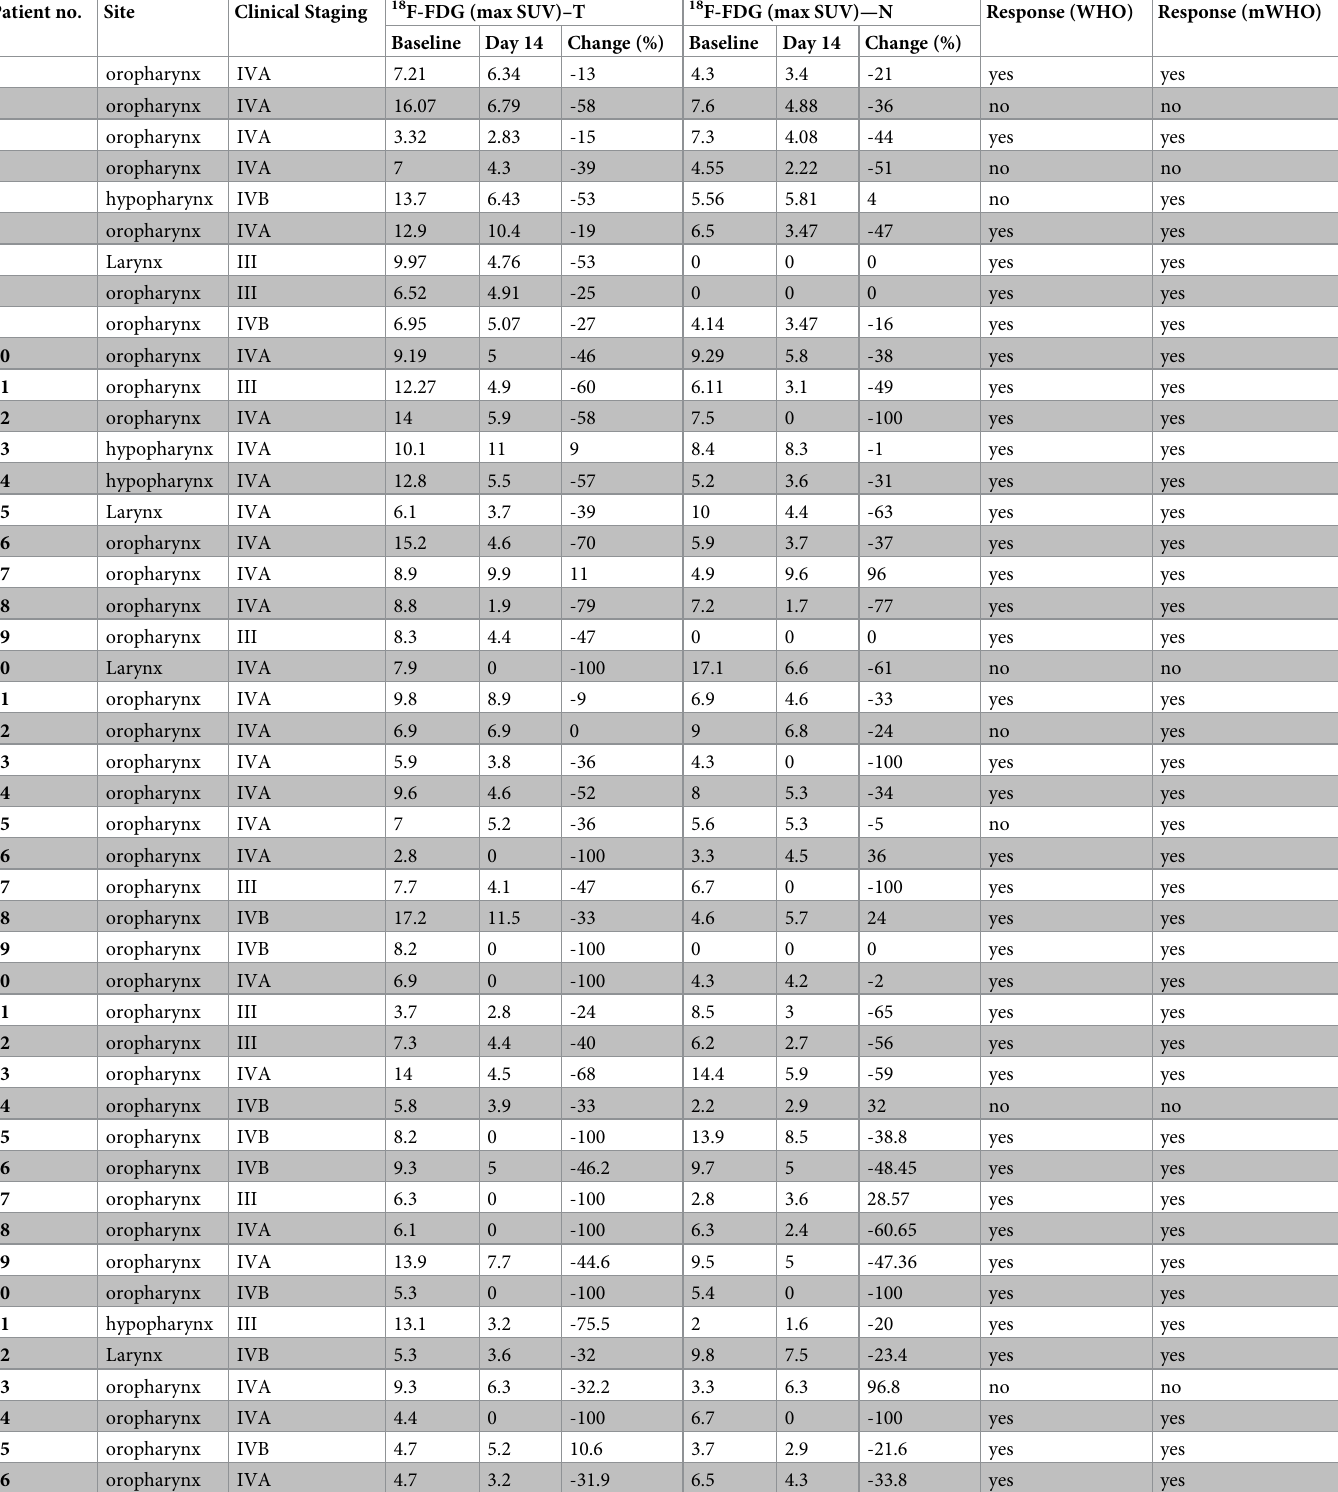
Table 2. Response to induction chemotherapy according to PET/CT. Patient no.